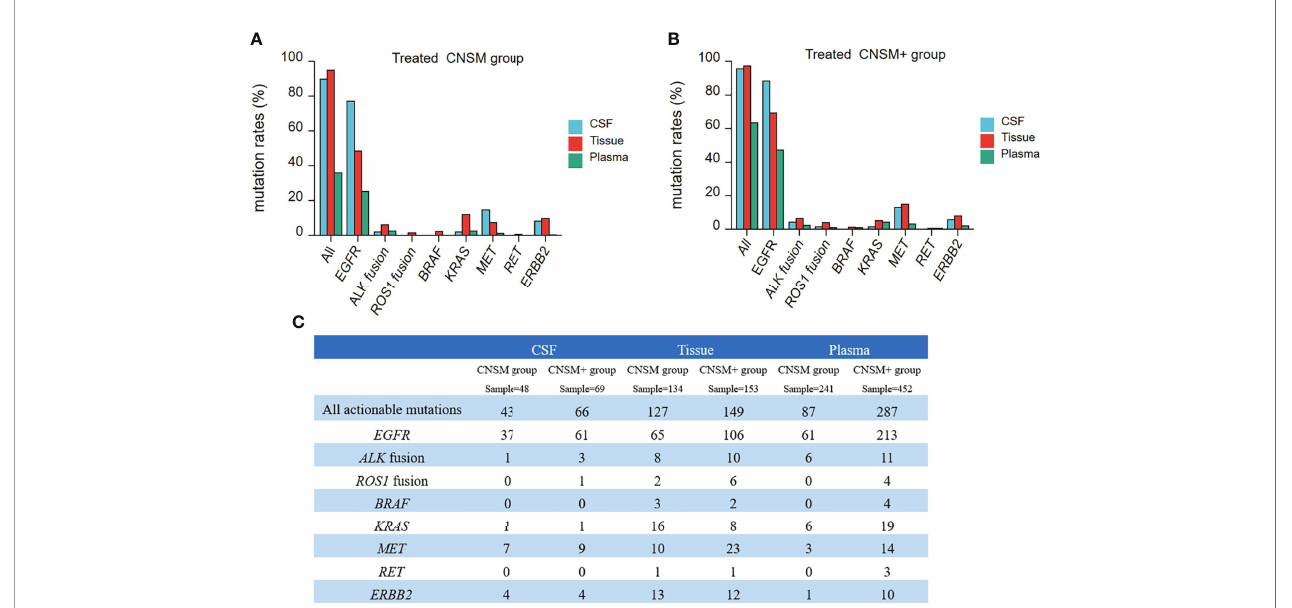
FIGURE 6 | Actionable mutations rates in treated NSCLC patients with CNS metastases. (A, B) The actionable mutation detection rates of different groups; (A) CNSM group: distant metastases only from the CNS group; (B) CNSM+ group: distant metastases other than CNS metastases group. (C) Actionable mutations detected in different samples from treated NSCLC patients with CNS metastases. CNSM group, patients had distant metastases only from the CNS, CNSM+ group, patients with other organ involvement and distant metastases other than CNS metastases.